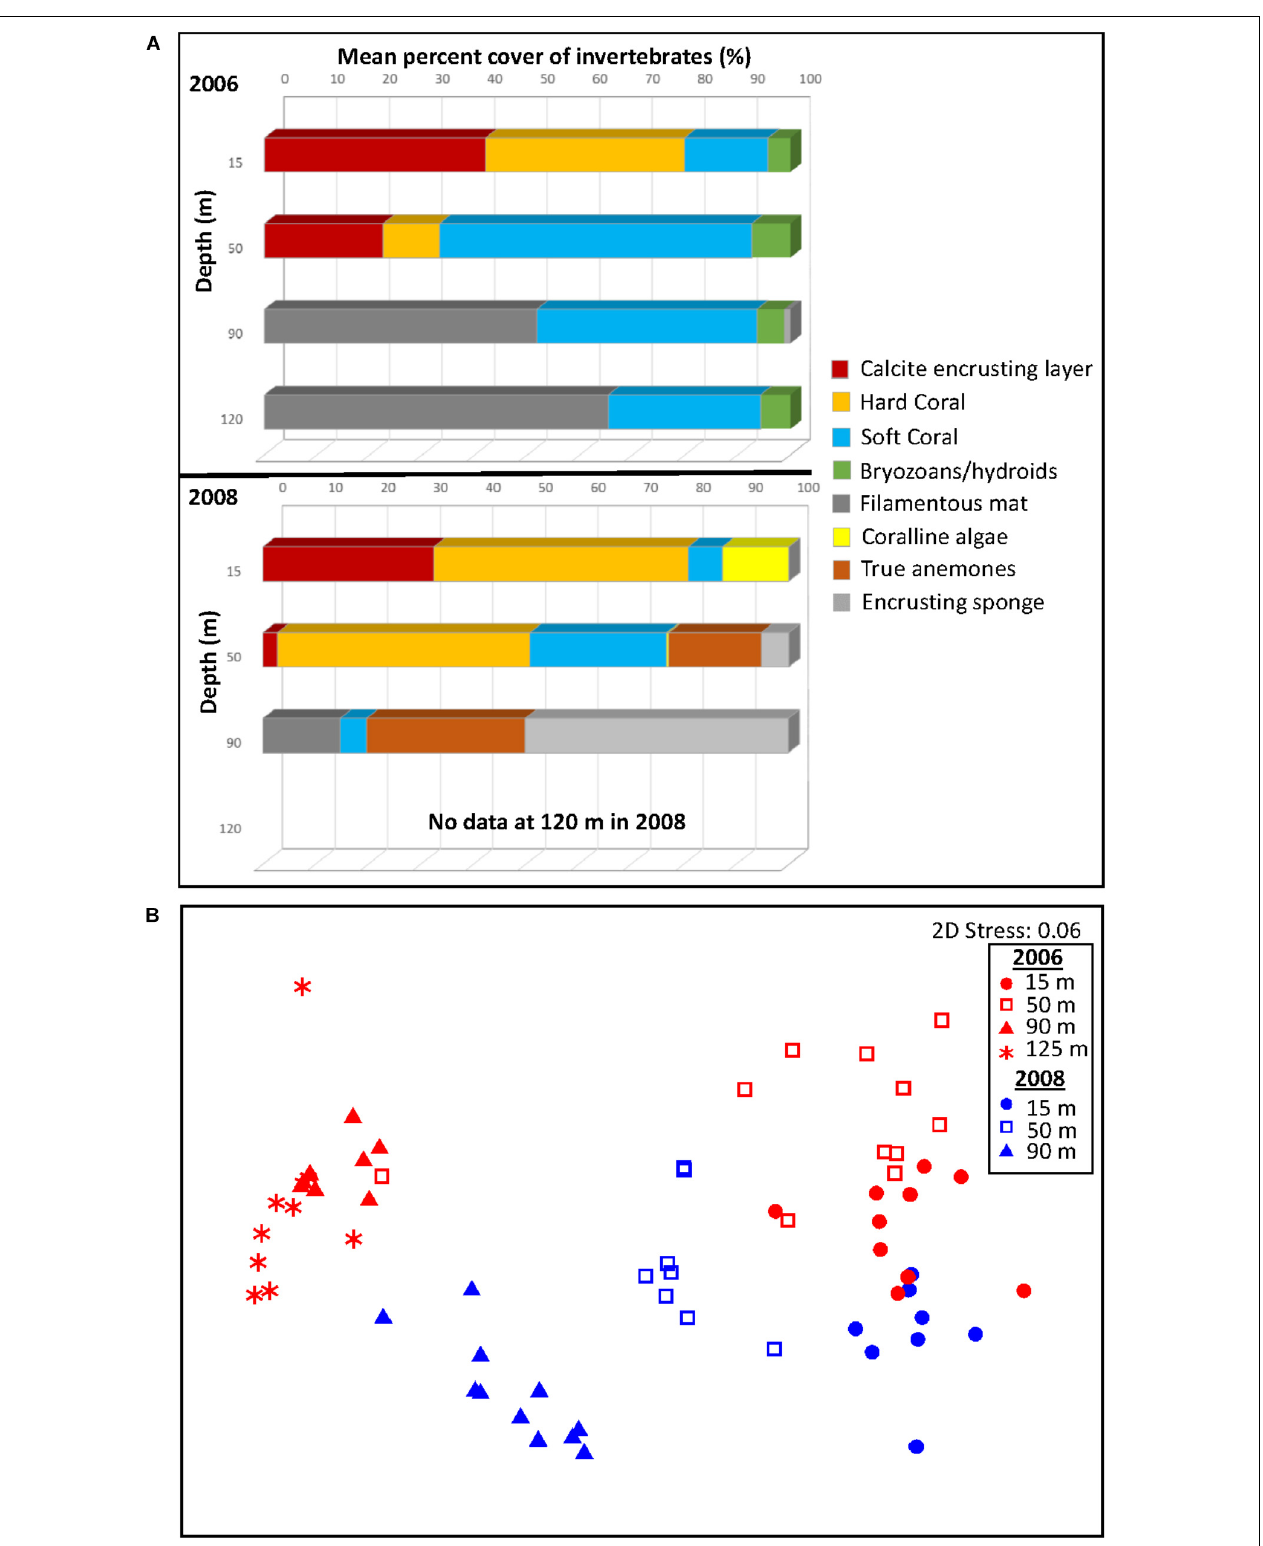
FIGURE 3 | Sessile attached invertebrate coverage and changes in coverage with depth and between years illustrated by (A) mean percent cover by the major invertebrate taxa/groups and (B) multidimensional scaling plot (MDS) of the sessile invertebrate species on the horizontal members of Goodwyn Alpha platform in 2006 and 2008. In the MDS, each data point represents a replicate quadrat. The MDS is constructed from Bray–Curtis similarities based on the percent coverage of different groups/species. There was no footage available for analysis of the sessile invertebrates from 125 m in 2008.